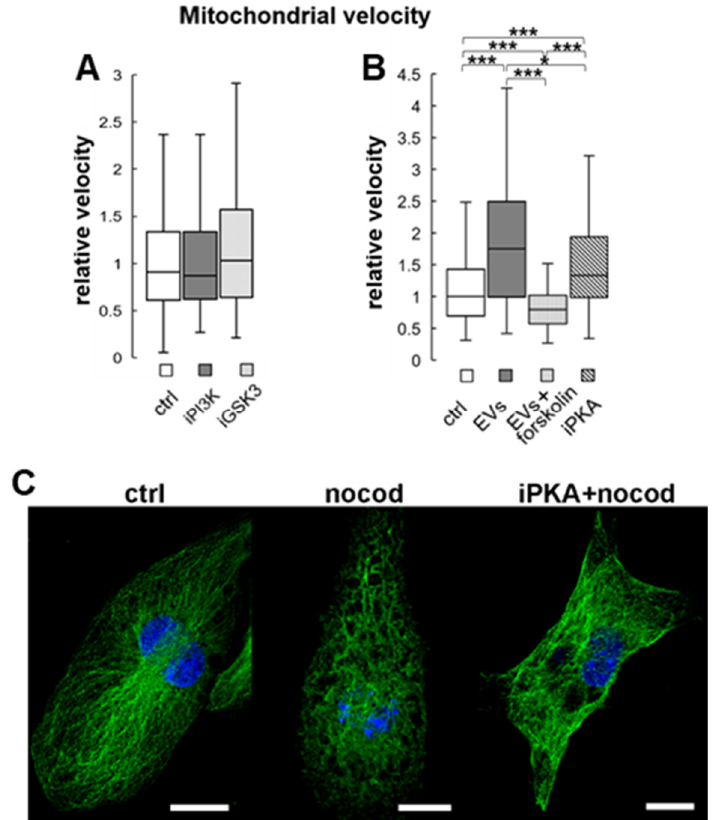
Figure 9. Changes in mitochondrial velocity under different treatments, and effects of nocodazole and PKA inhibitor on tubulin cytoskeleton in HL-1 cardiomyocytes. ( A ) The changes observed after 1h of PI3K or GSK3 inhibitor treatment. ( B ) The changes induced by extracellular vesicles (EVs) from cardiac fibroblasts and PKA pathway effectors. Data were normalized to control, and are presented as median and interquartile range. * p < 0.05, *** p < 0.001. ( C ) The effect of PKA inhibitor on nocodazole-induced disruption of MT cytoskeleton. Bar = 10 µm. Ctrl—untreated cells; EVs—extracellular vesicles-treated cells; EVs + forskolin—cells preincubated with adenylyl cyclase activator forskolin and treated with EVs; iPKA—cells treated with an inhibitor of the cAMP-dependent protein kinase A, nocod—cells treated with nocodazole; iPKA+nocod—cells preincubated with iPKA before the nocodazole treatment.